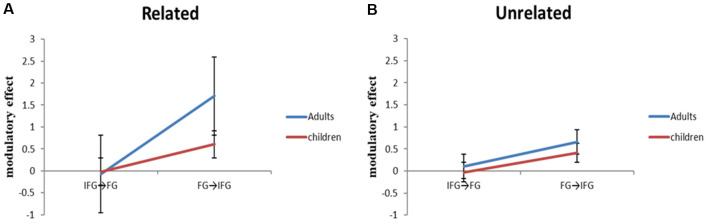
The adult group showed significantly stronger modulatory effects than the child group on the bottom-up connection from the fusiform gyrus (FG) to ventral inferior frontal gyrus (IFG), but not on the top-down connection from the IFG to FG. This difference was found in the related condition, but not in the unrelated condition.